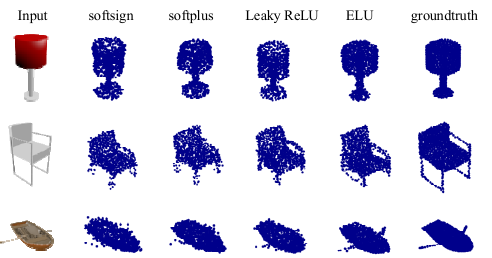
Figure 4. Visualization of 3D-SSRecNet’s output with different activation functions on ShapeNet. We compared our 3D-SSRecNet with PSGN [4], 3D-LMNet [5], SE-MD [24], 3D- VENet [25], 3D-ARNet [22], 3D-ReConstnet [6], and 3D-FEGNet [26]. All the experi- ments followed the same train/test split and used the same loss functions, CD and